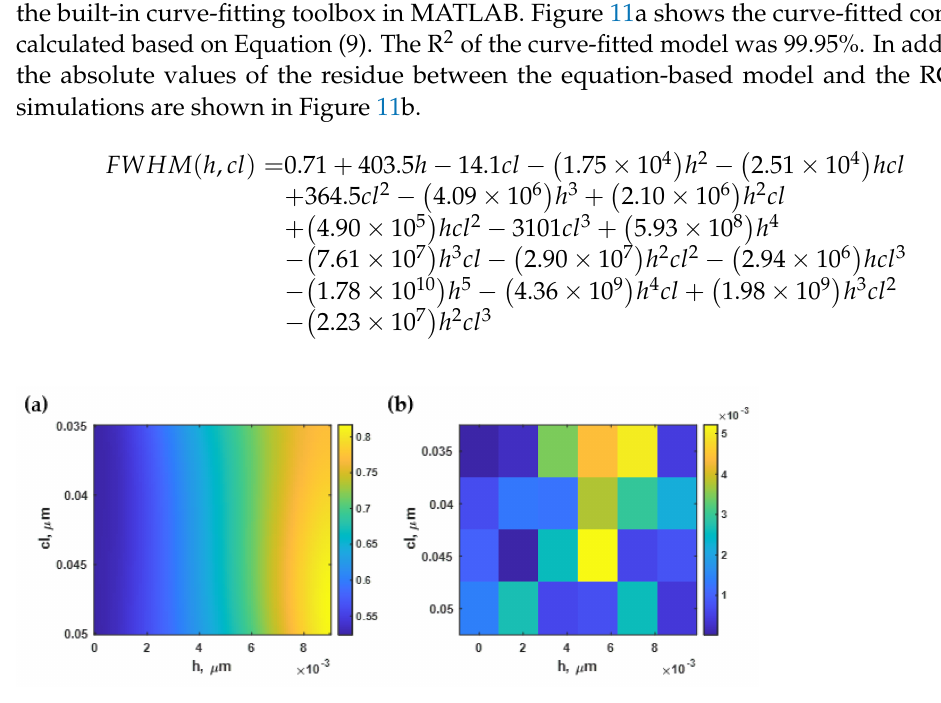
Figure 11. ( a ) The normalized full width at half maximum using Equation (9); and ( b ) the difference between Equation (9) and the RCWA